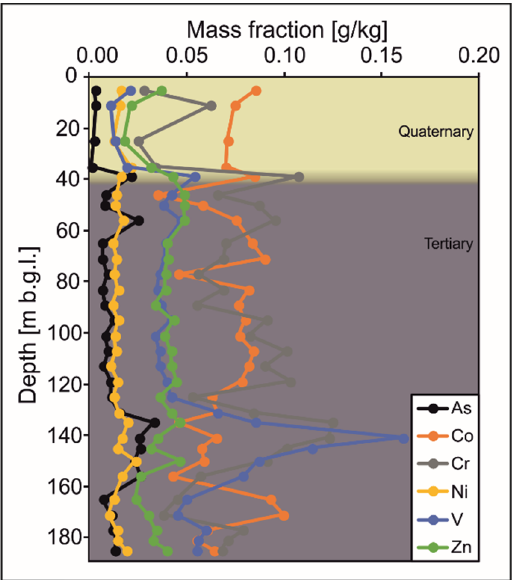
Figure 3. Trace element contents of the Quaternary–Tertiary.